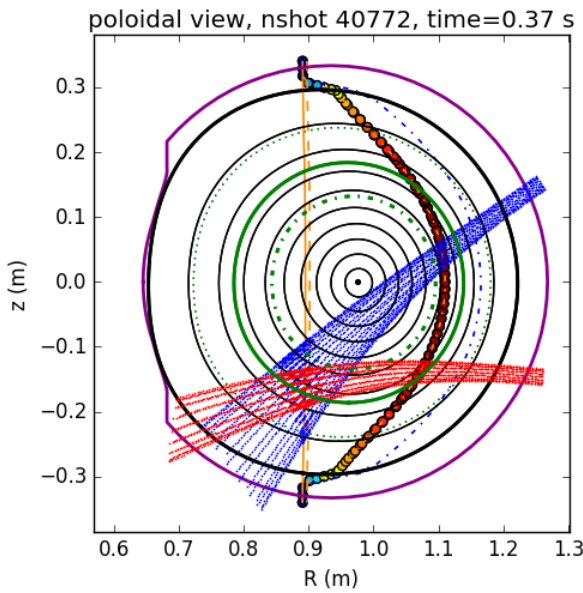
Fig. 8. Plasma equilibrium and resonances for shot #40772 with asymmetric launch: the probe beam intersects the island close to the UH resonance and then again the q=2 surface (solid circle in green) close to the EC resonance. The thin vertical (solid and dashed) lines correspond to the EC cold and warm resonances, while the UH resonance is marked by dots in colour. The q=1.5 and q=3 magnetic surfaces are also shown as dashed-dotted